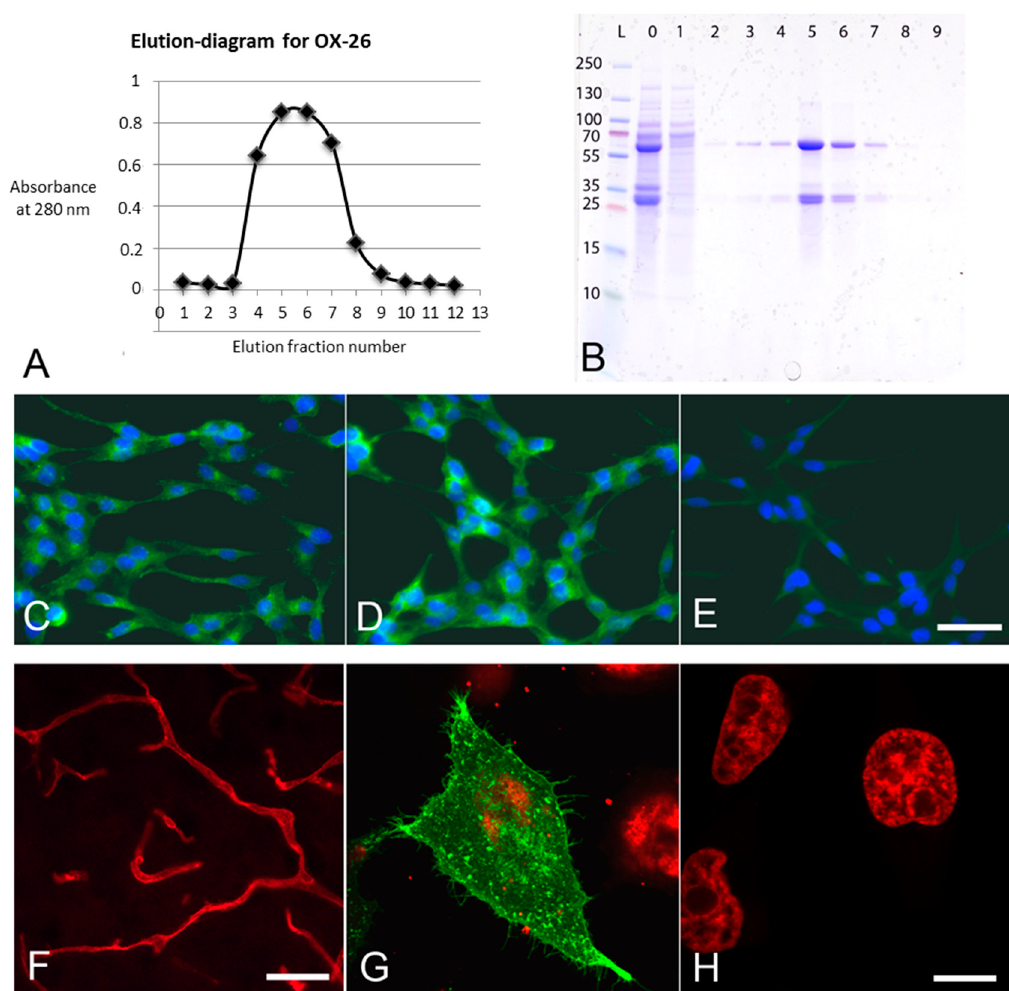
Figure 2. Specificity of OX26-monoclonal antibodies (MAbs). ( A ) Elution diagram of collected OX-MAbs. X-axis: elution fraction number; y-axis: absorbance at 280 nm. ( B ) Coomasie Blue-stained SDS gel. Lane L, protein ladder (kDa). Lane 0, sample of antibody suspension before running